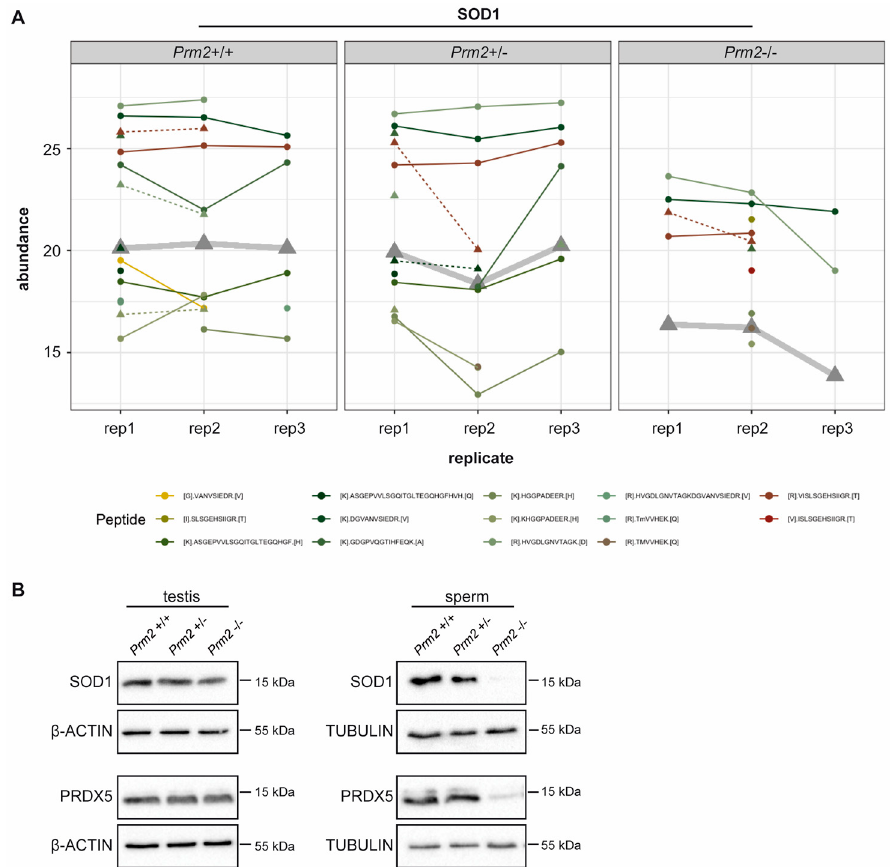
Figure 3. ROS scavenger proteins SOD1 and PRDX5 are downregulated in Prm2 -deficient sperm. ( A ) Profile plots showing the relative abundance of identified SOD1 peptides within each replicate of Prm2 +/+ , Prm2 +/ − and Prm2 − / − sperm. The protein abundance calculated by Tukey´s median polish is resembled by thickened grey lines. ( B ) Representative immunoblot against SOD1 and PRDX5 on protein lysates from Prm2 +/+ , Prm2 +/ − and Prm2 − / − testes and epididymal sperm ( n = 1–3). Beta-actin and tubulin served as loading control.